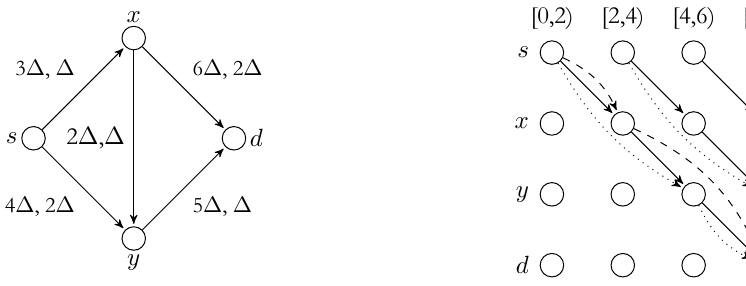
Figure 4: The condensed graph corresponding to Figure 1(b) and its time expansion with ∆ = 2